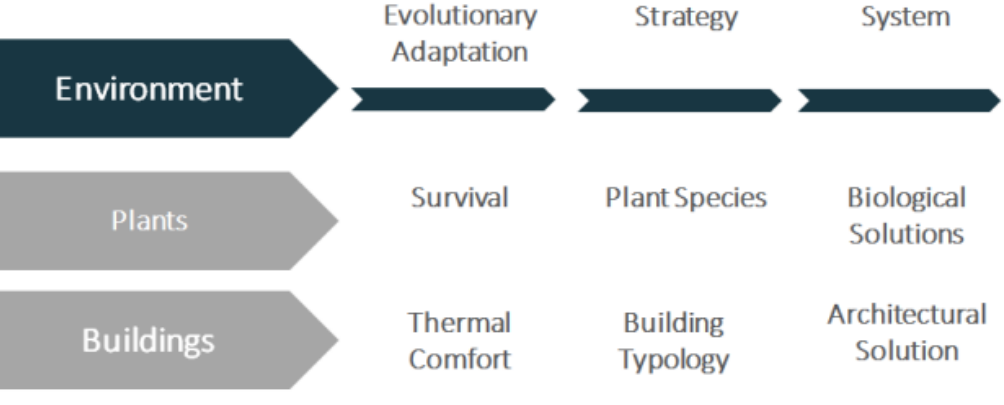
Figure 5: Concept scheme showing the main objective of the study (The researcher, 2020)